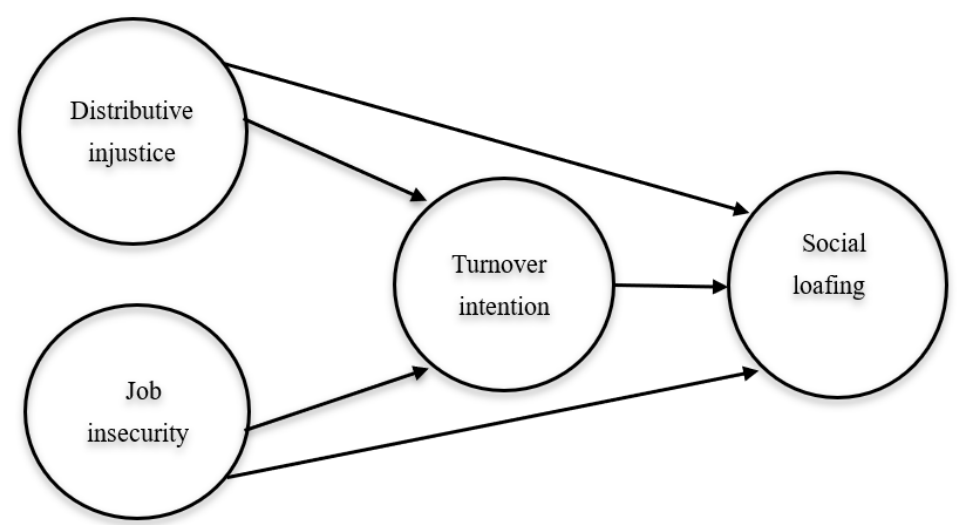
Figure 1. The research conceptual model.